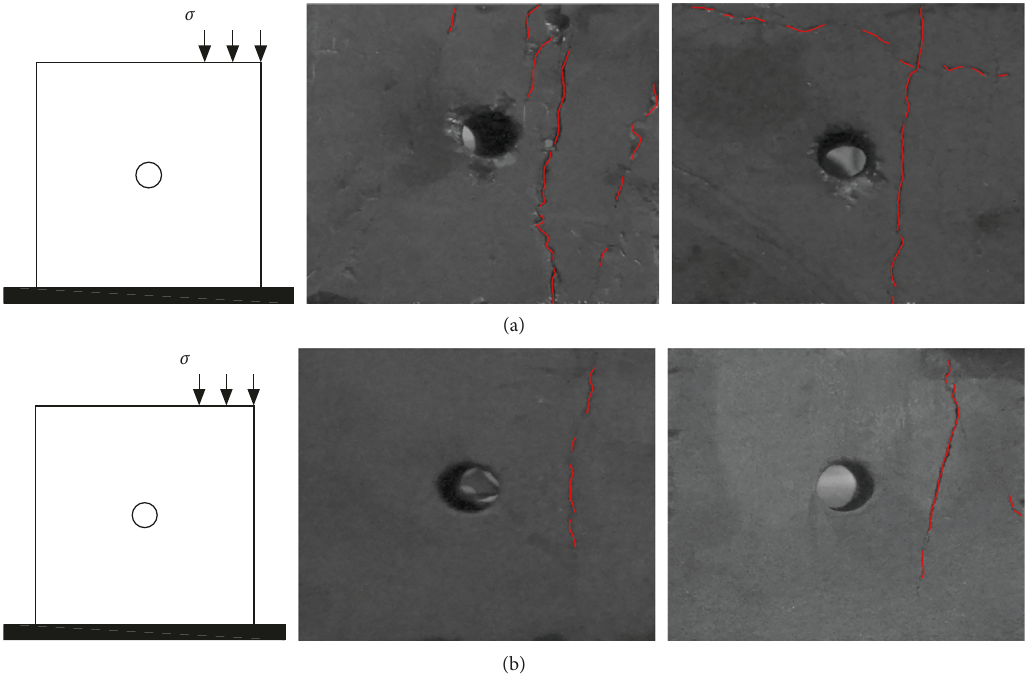
Figure 9: Action area of S/4. (a) Coal samples; (b) briquette